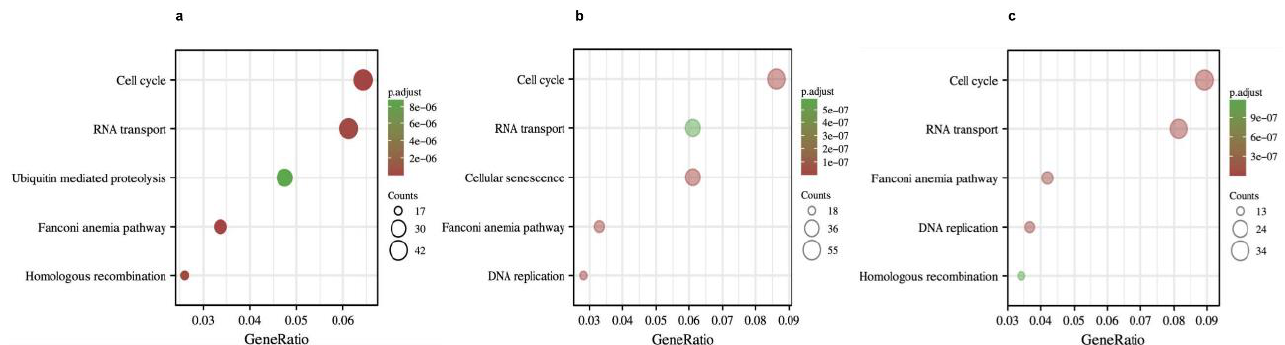
Figure 7. GO analysis of BRCA1 , BRCA2 co-expression genes, and intersection co-expression genes among BRCA1/2 . ( a ) GO analysis of BRCA1 , ( b ) GO analysis of BRCA2 , ( c ) GO analysis of co-expression genes, and intersection co-expression genes among BRCA1/2 . GO: Gene Ontology.